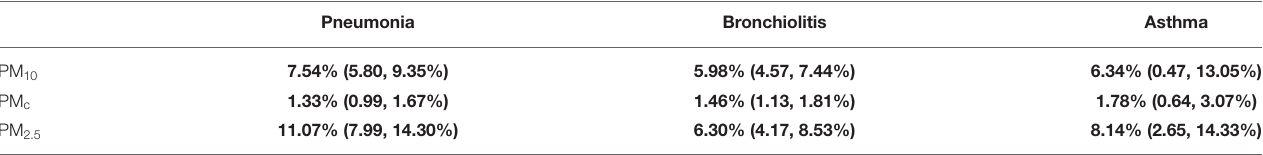
TABLE 4 | Counterfactual analysis on the percent of decline (95% confidence intervals) in acute lower respiratory infection outpatient visits if the level of PM 2.5 , PM c , and PM 10 were reduced to the reference levels in Guangzhou from 2013 to